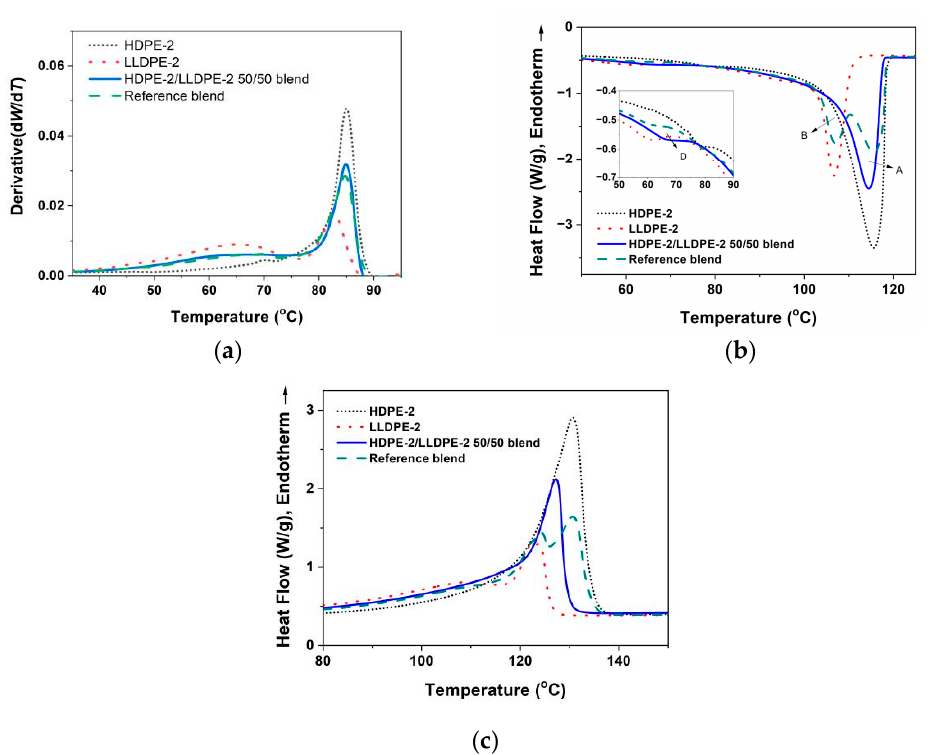
Figure 11. CRYSTAF curves of HDPE-2, LLDPE-2, and the HDPE-2/LLDPE-2 50/50 blend. ( a ) DSC cooling curves ( b ) and second heating curves ( c ) of the HDPE-2/LLDPE-2 50/50 blends compared with calculated reference blend curves. “A”/“B”/“D” in the figures indicates the area between the HDPE-2/LLDPE-2 50/50 blend curve (solid line) and the reference blend curve (dashed line) at the corresponding locations.